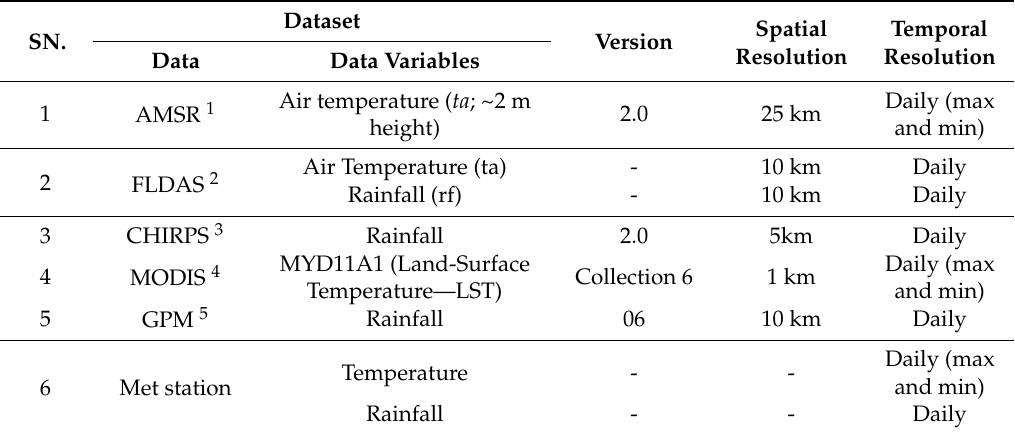
Table 2. Satellite interpolated and meteorological datasets used in this study with their characteristics and descriptions.